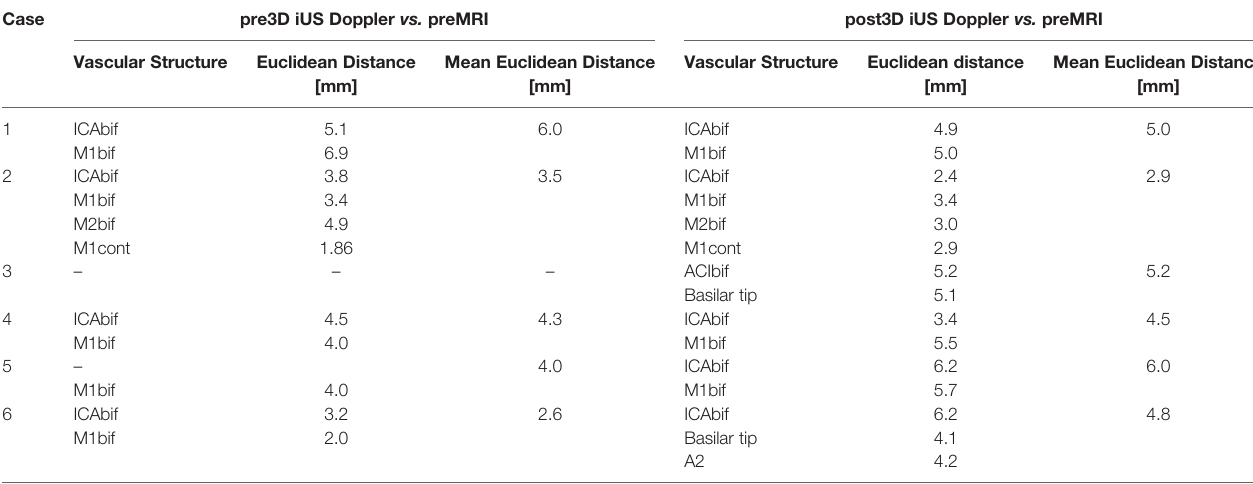
TABLE 2 | Measurements.